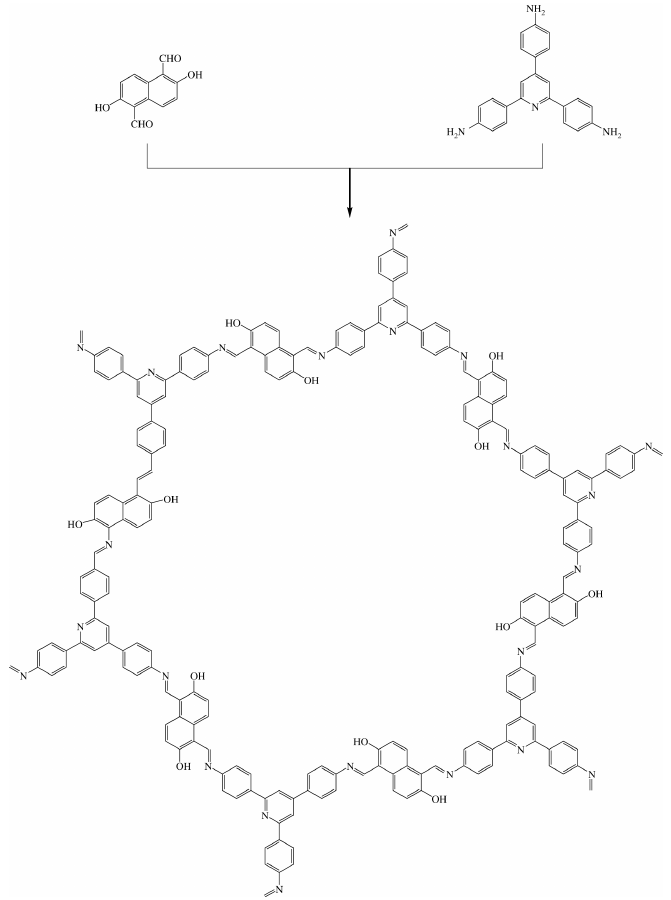
Figure 22: Synthesis of COFs by Condensation of 2,6-Dihydroxynaphthalene-1,5-dicarbaldehyde (DHNDA) and 2,4,6- tris(4-aminophenyl)-pyridine